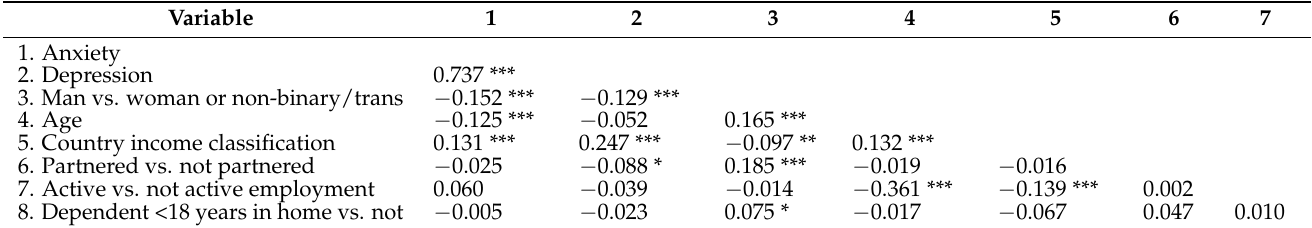
Table 2. Correlation Matrix among Demographic Variables and Depression and Anxiety.